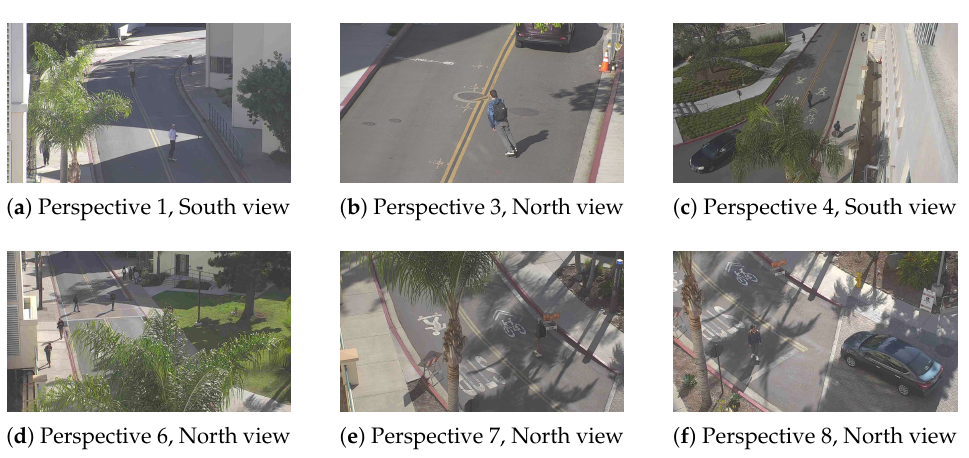
Figure 4. Images were obtained from eighteen different camera perspectives configured with different pan, tilt, and zoom values, shown in Table 1. Six selected perspectives are shown in sub-figures ( a – f ). Table 1. Camera perspective configuration